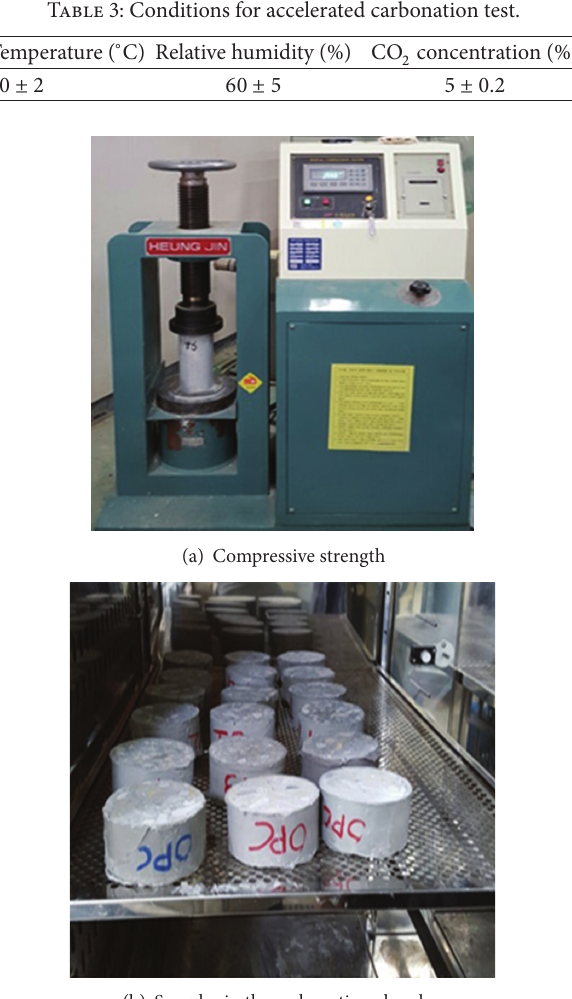
Figure 2: Photos for compressive strength and carbonation